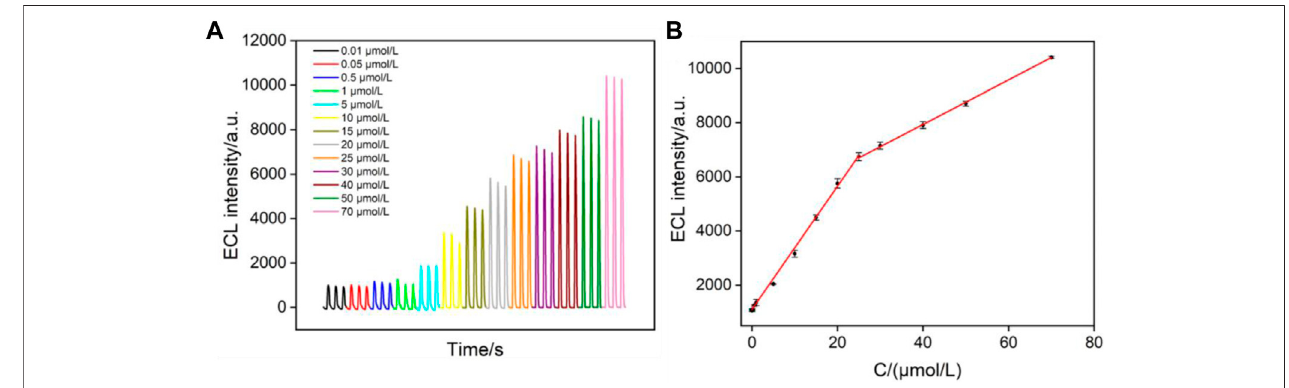
FIGURE 5 | (A) ECL intensity of Ru (bpy) 32+ in the presence of different concentrations of clindamycin. (B) Linear dependence between the ECL intensity and the concentration of